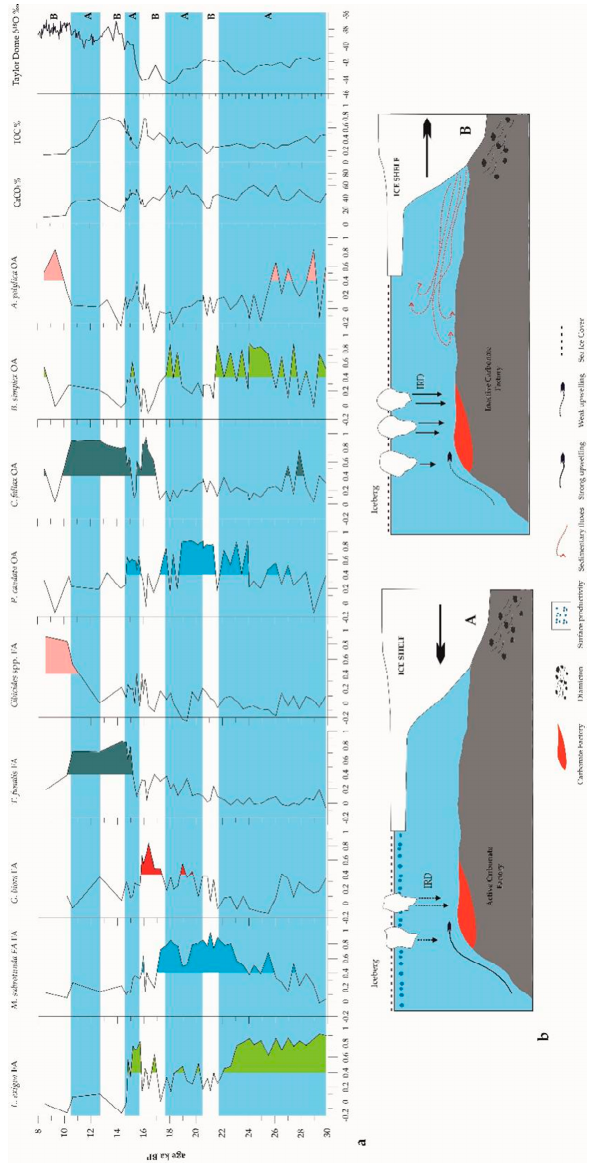
Figure 6. ( a ) Down-core distribution of the foraminiferal (FAs) and ostracod assemblages (OAs) based on the Principal Component Analysis (statistically significant loading values > 0.4, as suggested in [48], are depicted using various colours) together with the percentage values of CaCO 3 and TOC and δ 18 O curve. Blue areas (letter A) and uncoloured areas (letter B) depict, respectively, the advance and the retreat glacial phases, which a ff ected the Cape Adare area from 30.0 ka up to the definitive Holocene glacial retreat (up to 11.0 ka BP). ( b ) Paleoenvironmental reconstruction of the carbonate deposition at the Cape Adare area, northwestern Ross Sea, Antarctica, modified from [10], in relation to the ice shelf variations, using the results from FAs, OAs and abiotic data. A-Active carbonate factory. The expansion of the ice shelf inhibits the contributions of the terrigenous material, allowing a development of the carbonate factory. At the same time, the expansion of the sea ice reduces the influence of bottom currents and disturbance of the bottom communities caused by the transit of icebergs (high IRD, scouring phenomena). During the period of glacial expansion, there is an increase in nutrient fluxes resulting from increased upwelling (high CDW). B-Inactive carbonate factory. The withdrawal phases of the ice shelf generate high flows of sedimentary material from the melt water runo ff and iceberg detachment, which reduces the deposition of the carbonate material. Some decreased flows of organic material are likely to be caused by a possible concomitant reduced CDW